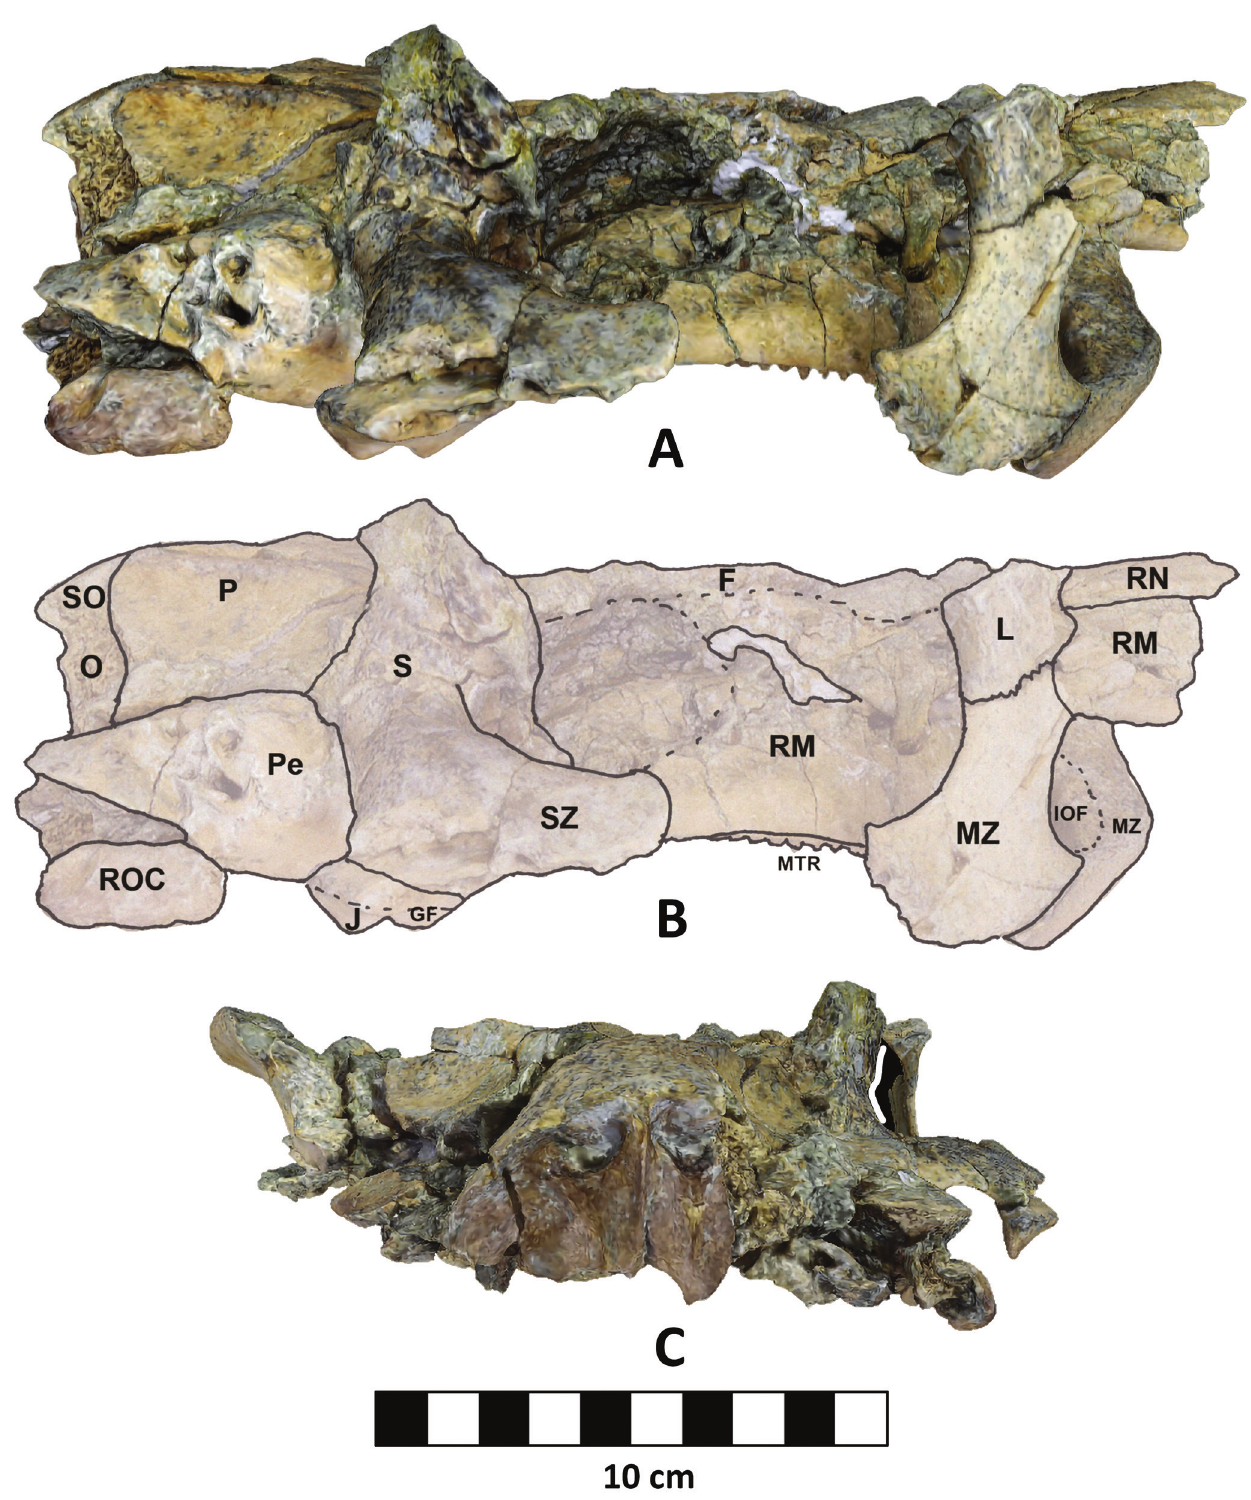
Figure 6. SDSNH 50000. A & B, lateral view; C, posterior view. In B, the boundaries of the bones are approximations, as the crushed condition of the skull prevented determining actual suture lines in many cases. Abbreviations: F, frontal; GF, glenoid fossa; J, jugal; L, lachrymal; MTR, maxillary tooth row; MZ, zygomatic process of maxilla; O, occipital; P, parietal; Pe, petrosal; RM, right maxilla; RN, right nasal; ROC, right occipital condyle; RPt, right petrosal; S, squamosal; SO, supraoccipital; SZ, zygomatic process of squamosal. Unlabeled areas are either fragments of bone which could not be allocated to a specific element, areas of crushed and comminuted bone, and matrix, or are gaps between bones where fragments have separated or are